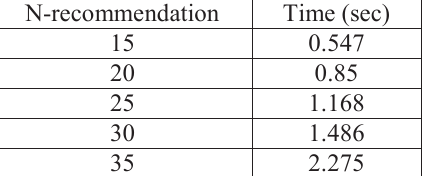
Table 5. N-recommendation vs Time